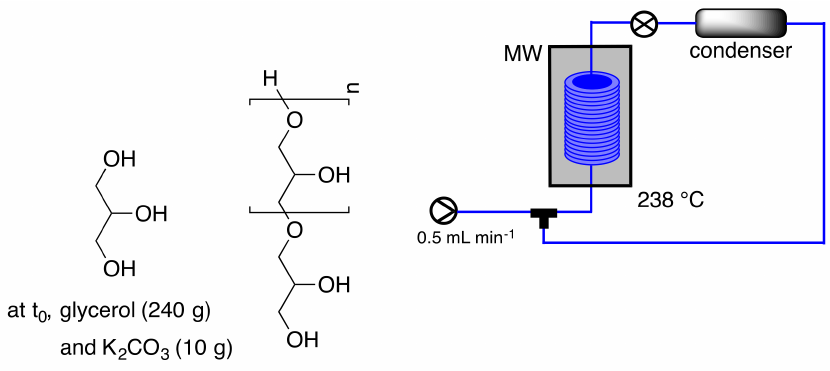
Figure 2. Cyclic microwave-assisted continuous oligomerization of glycerol in a gram